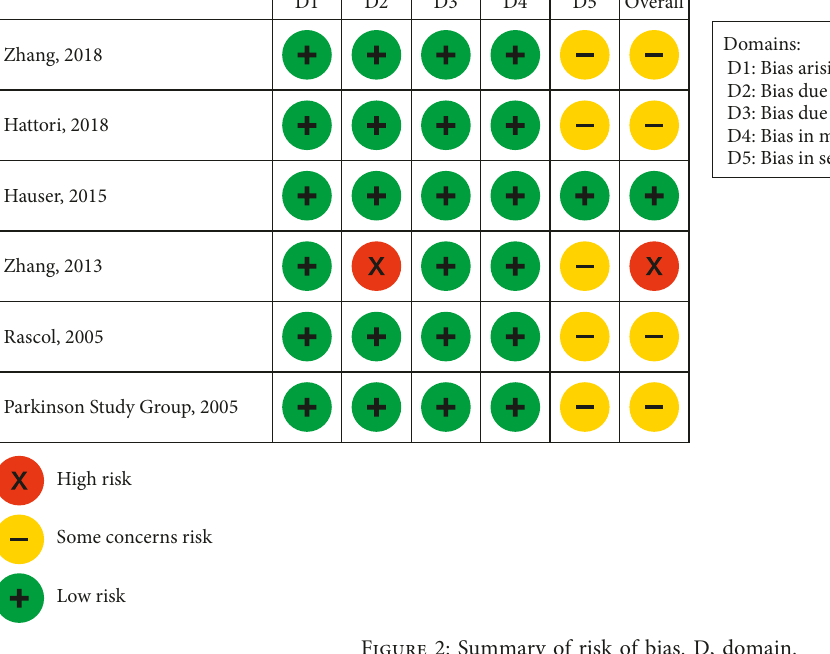
Figure 2: Summary of risk of bias. D,